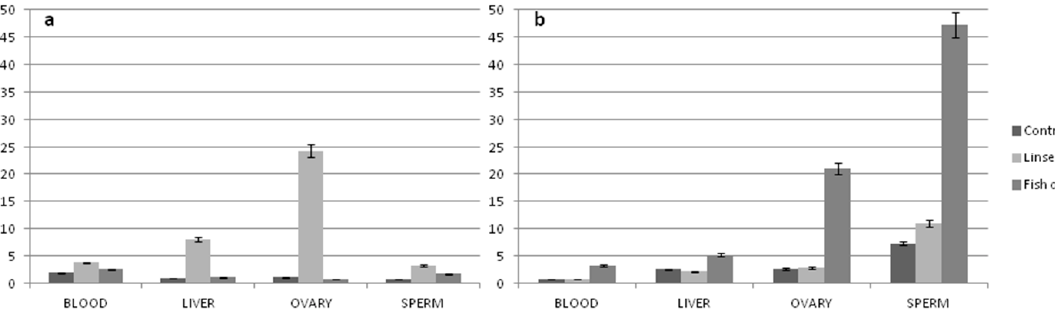
Figure 2. Fatty acids deposition in different tissues of rabbits fed different n-3 PUFA dietary sources (linseed or fish oil). ( a ) α -linolenic acid (ALA) distribution (% of total fatty acids) and ( b ) n-3 LC-PUFA distribution (% of total fatty acids).